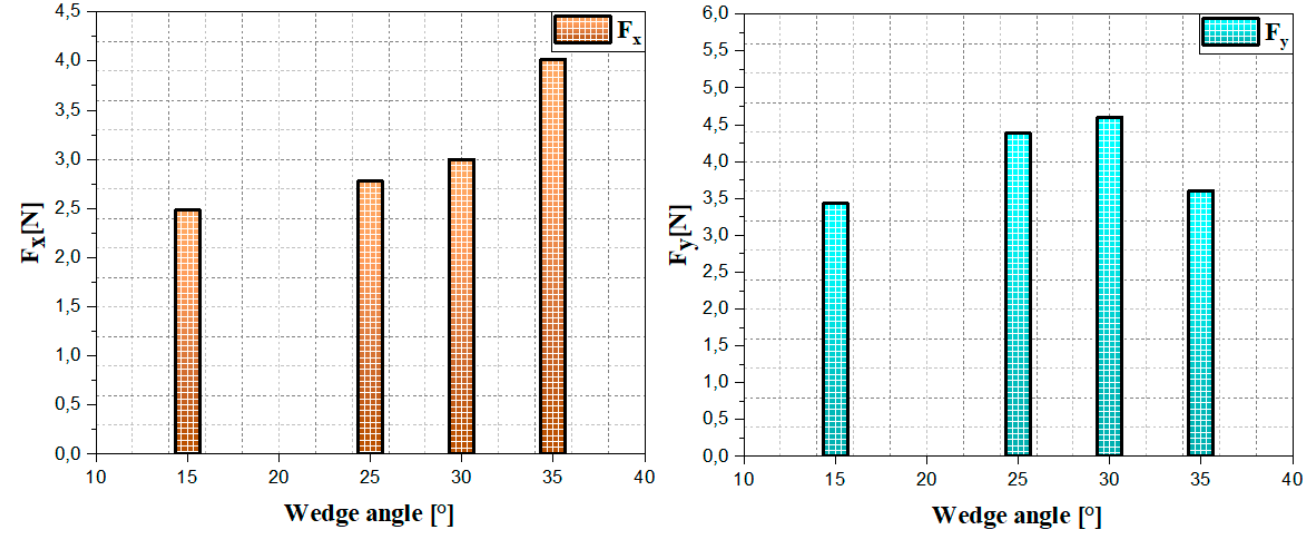
Figure 25. Evolution of F x and F y .